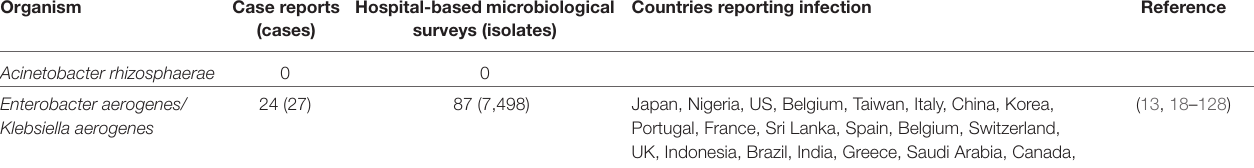
taBLe 1 | Case reports and hospital microbiological surveys reporting infections caused by saprophytic Gram-negative bacteria (GNB) species previously identified on retail spinach [Raphael et al